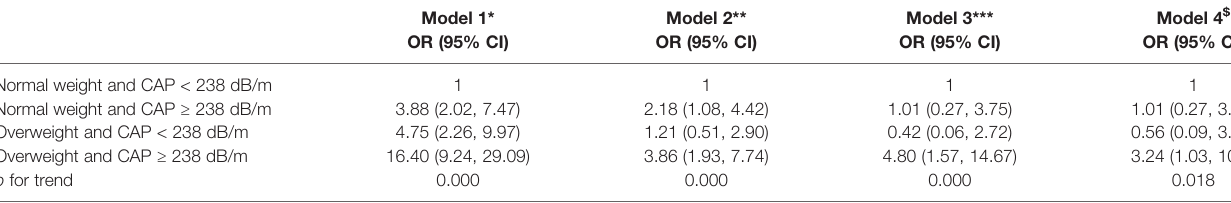
TABLE 5 | Odds ratio of having MetS in normal-weight versus overweight subjects with or without hepatic